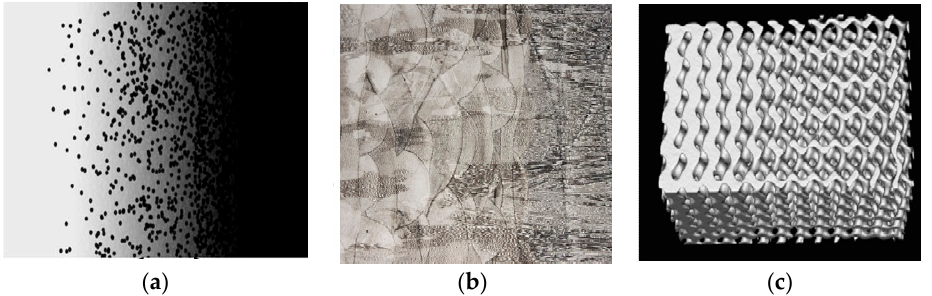
Figure 2. Classification of functionally graded material (FGM) according to ( a ) composition [93]; ( b ) microstructure [92]; ( c ) porosity [94].